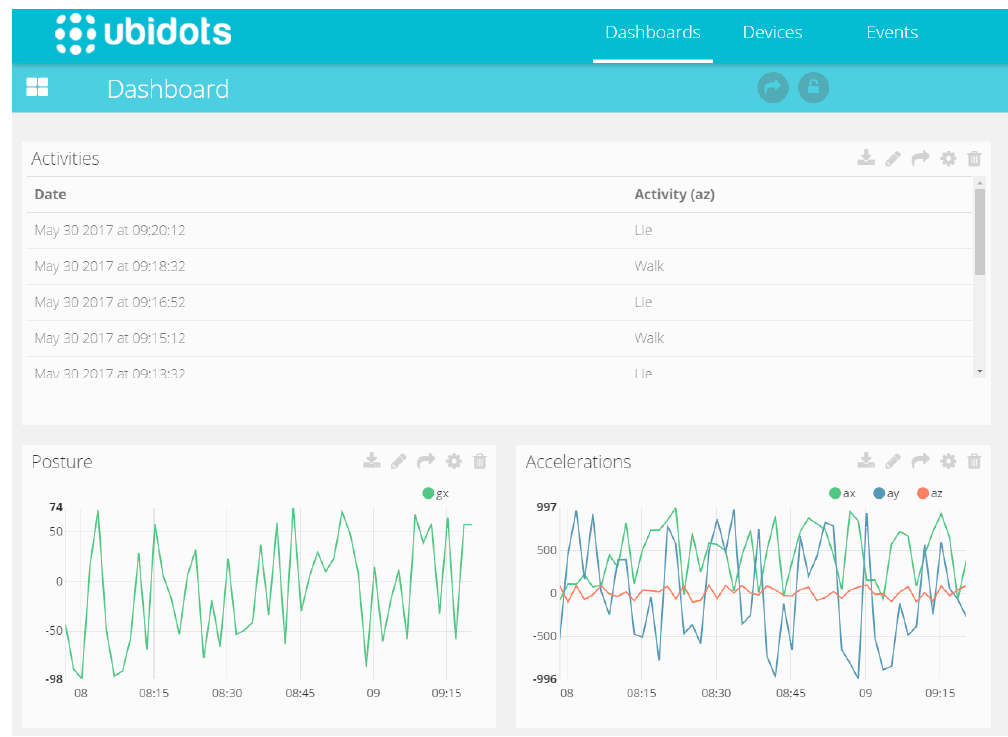
Figure 6. Example of the data visualization on the cloud